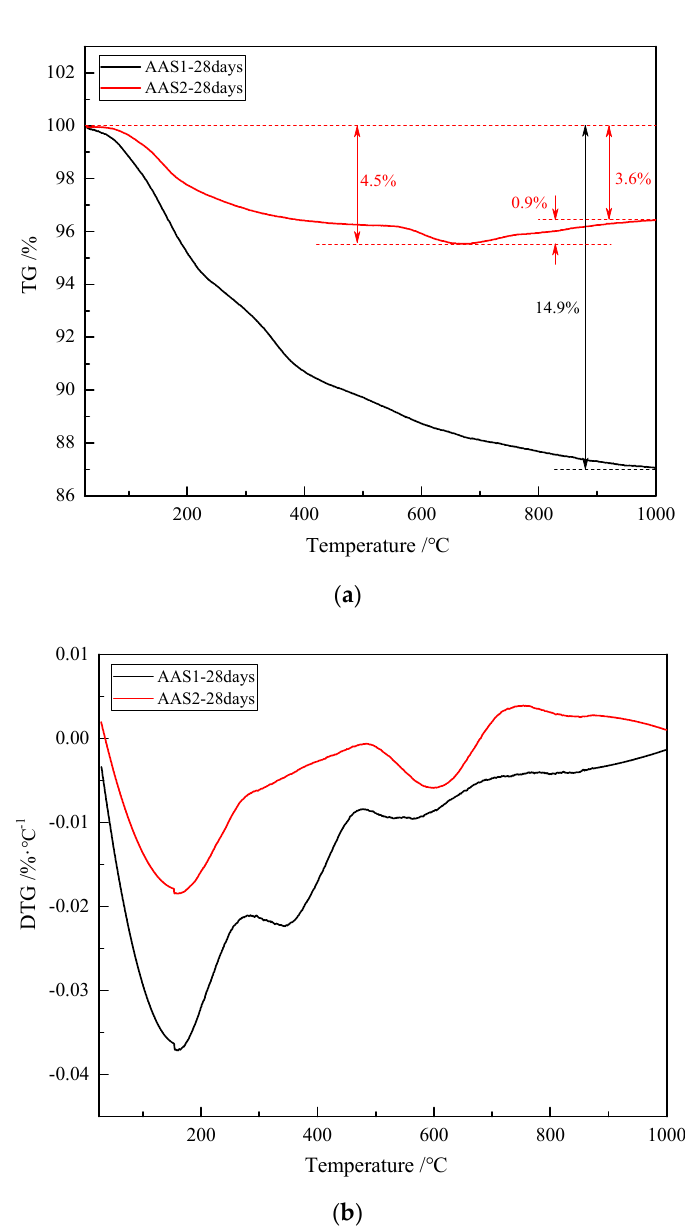
Figure 5. TG and DTG curves of the AAS. ( a ) TG curves and ( b ) DTG curves.